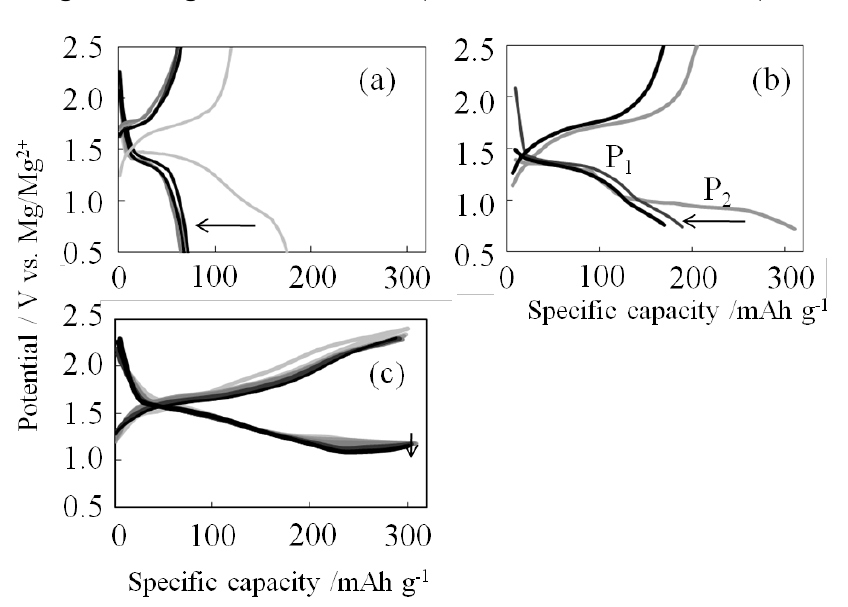
Figure 2. Charge-discharge curves: ( a ) V